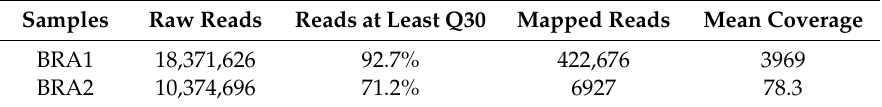
Table 2. Summary statistics for the two equine infectious anemia virus sequenced